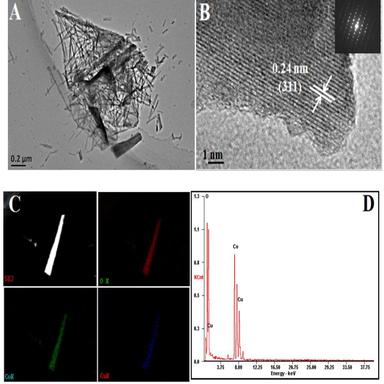
(A) Low-magnification TEM images, (B) HRTEM images, (C) EDS mapping, and (D) EDX spectrum of the elements Co, Cu and O; The inset in (B) is the corresponding SAED pattern.